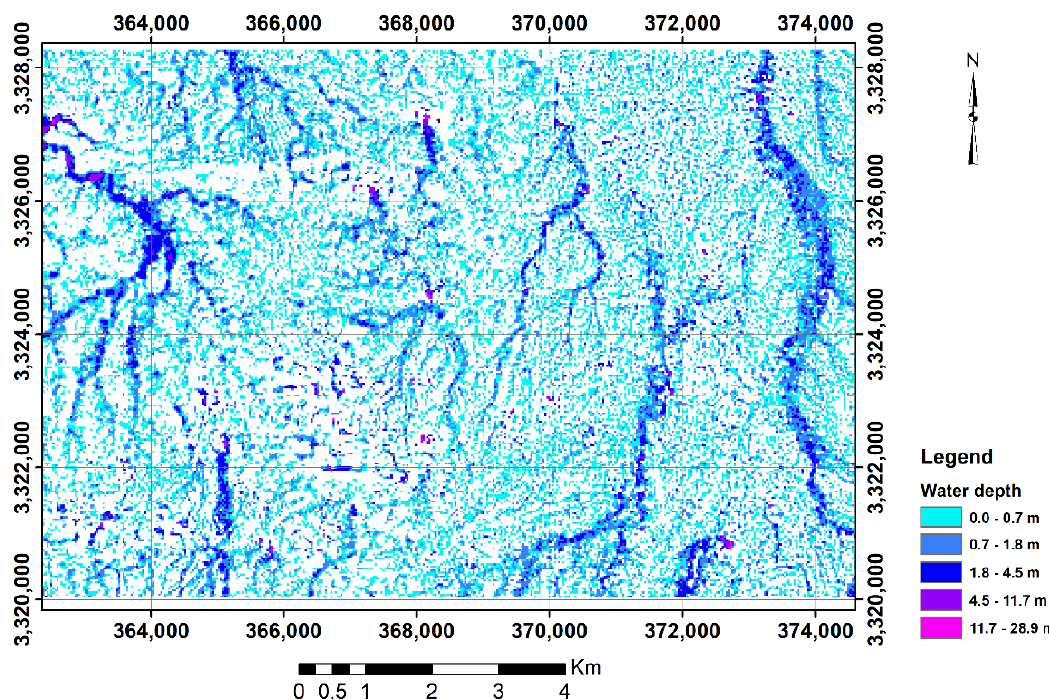
Figure 5. Simulated water depth using HEC-RAD 2D.